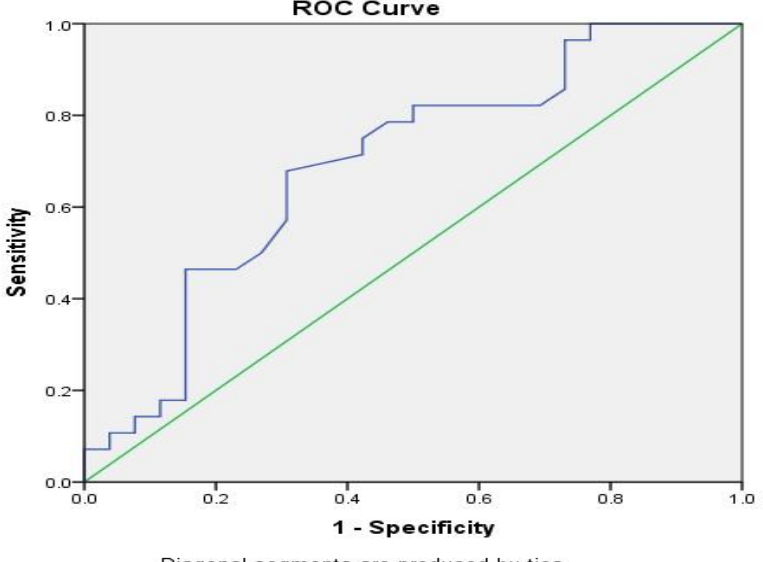
Figure 3. ROC curve for serum activin A on the 2nd day of life between neonates with or without neonatal brain injury. Area under the curve 69.2%, p = 0.015, 95%; Confidence Interval: 54.9–83.6%.